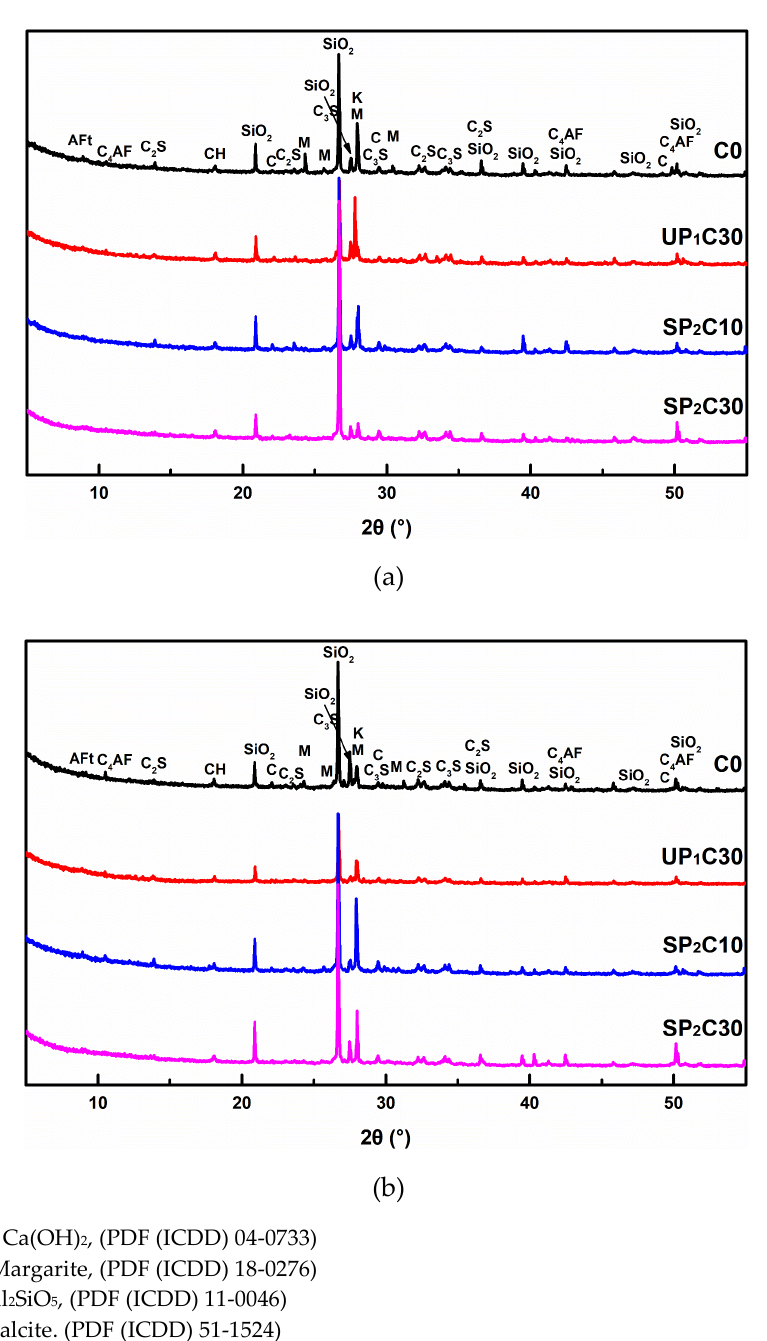
Figure 8. XRD pattern of UHPC hardened paste formed with pre-humid pumice at 7 d and 28 d age: 395 ( a ) 7 d age; ( b ) 28 d age. 396 ( a ) 7 d age; ( b ) 28 d